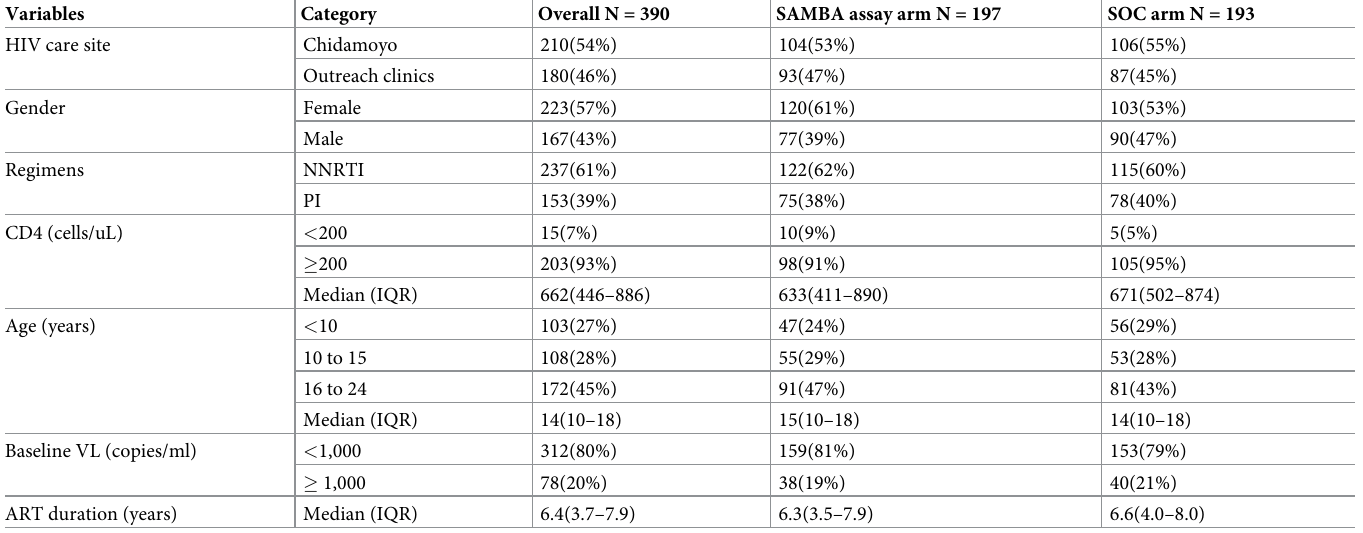
Table 1. Participant characteristics at